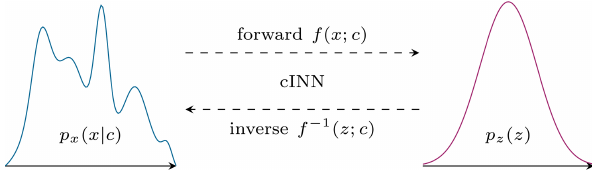
Figure 6. Schematic view of the transformation between the input features x and the latent space z for a given condition c performed by the conditional invertible neural network (Noever-Castelos et al.,